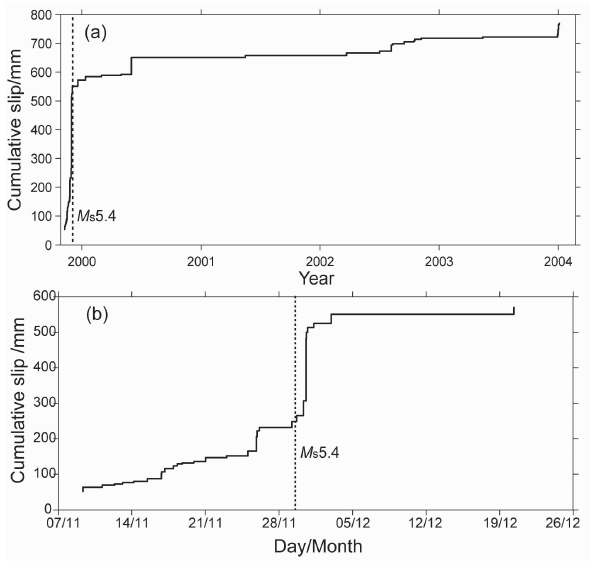
Fig. 5. (a) Cumulative slip plot for all the events of the Xiuyan 52-plet, with the vertical dashed line indicating the origin time of the 1999 Xiuyan M s =5.4 earthquake (which is not belonging to this 52-plet and accordingly not shown in the cumulative slip plot). (b) Zooming-in of Fig. 5a, with the vertical dashed line indicating the origin time of the 1999 Xiuyan